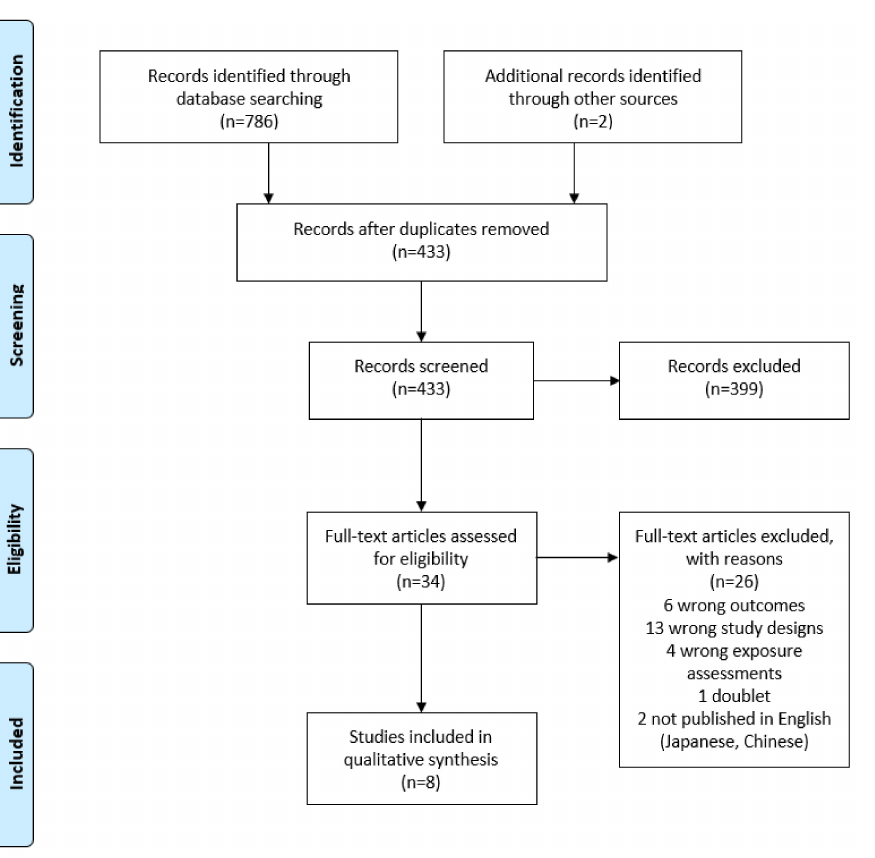
Figure 1. Flowchart for selection of included